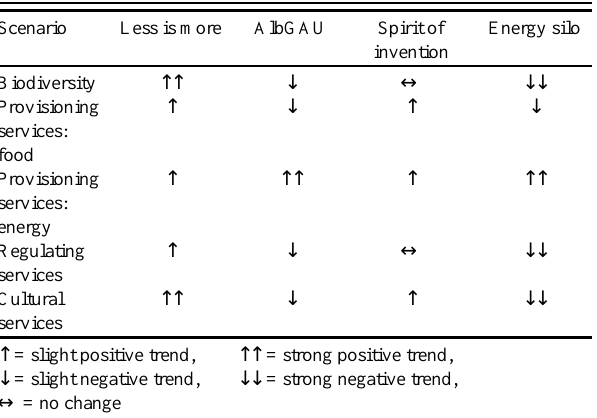
Table 2 . Impacts of scenarios on biodiversity and ecosystem